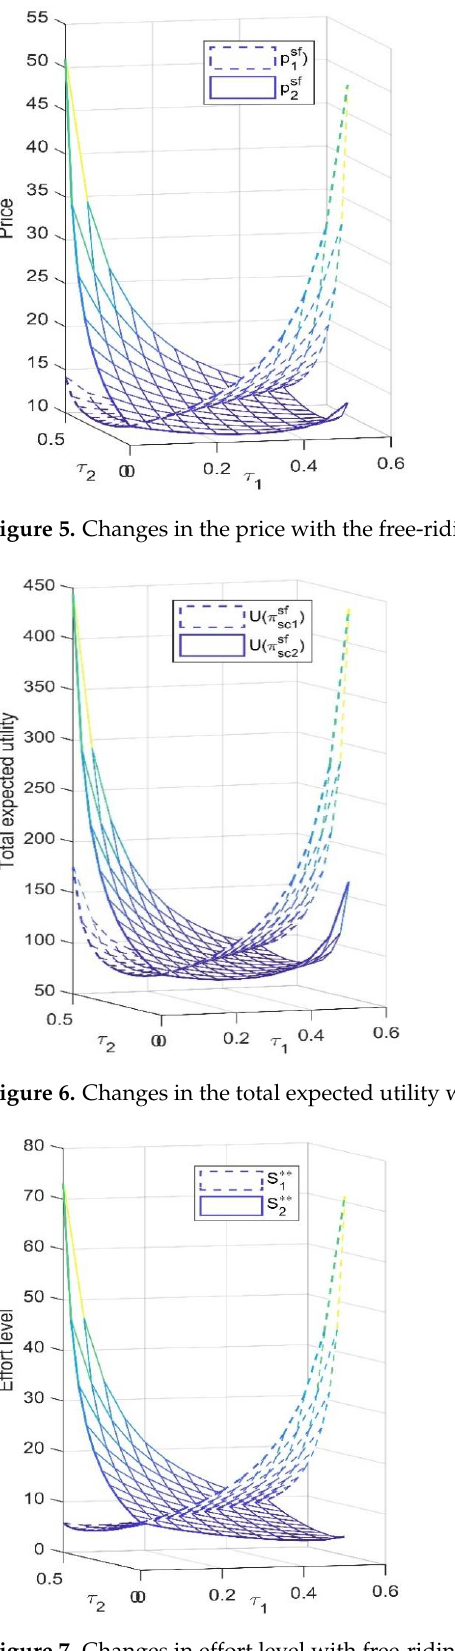
Figure 7. Changes in effort level with free-riding coefficient in the fourth case.